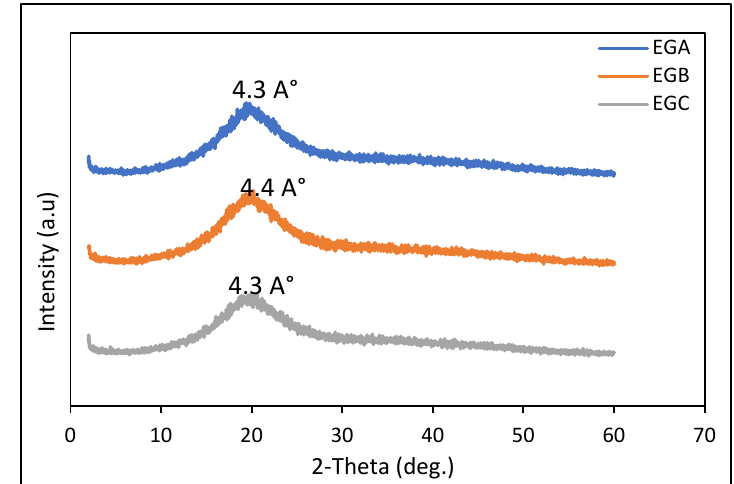
Figure 2. X-ray diffraction (XRD) patterns of EGA, EGB and EGC.